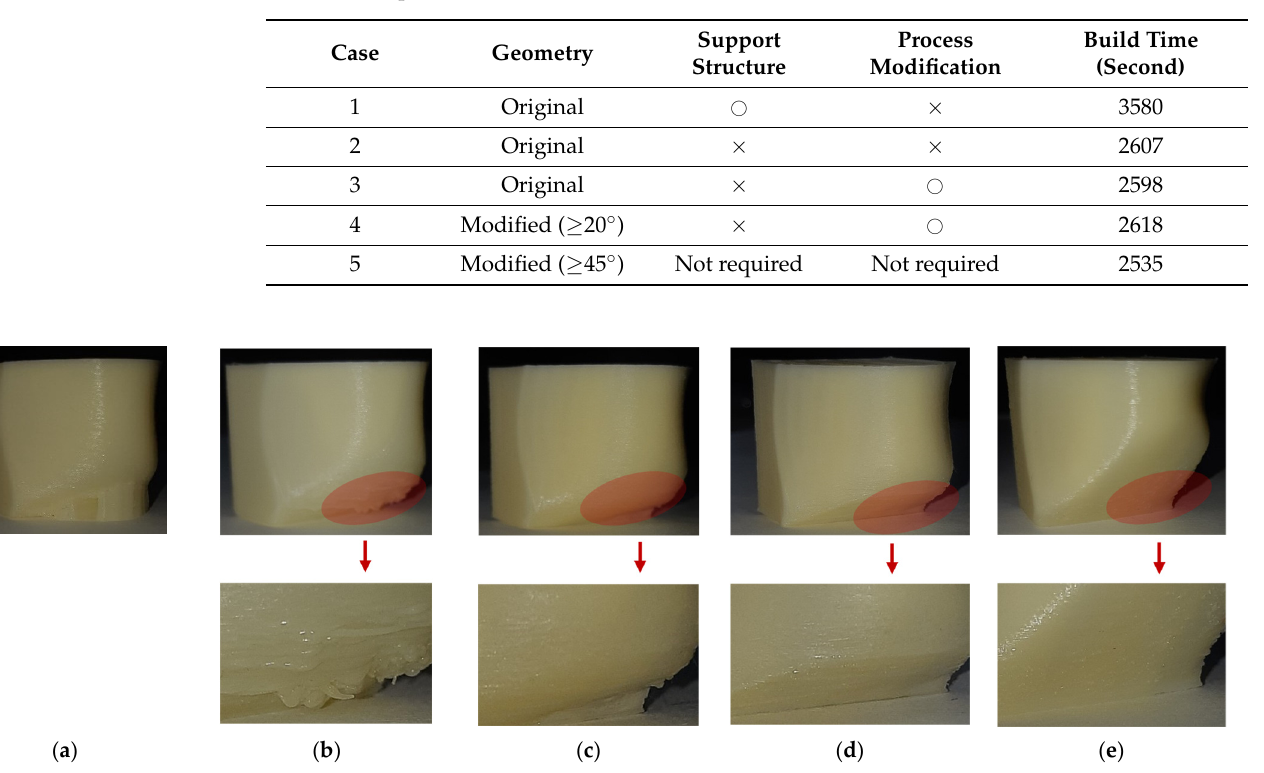
Figure 14. Comparison of as-fabricated models: ( a ) Case 1, ( b ) Case 2, ( c ) Case 3, ( d ) Case 4, ( e ) Case 5.